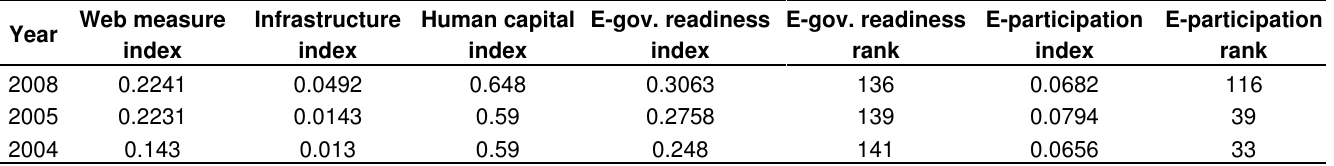
Table 2. Nigeria e-readiness/e-participation index 2004/2005/2008.